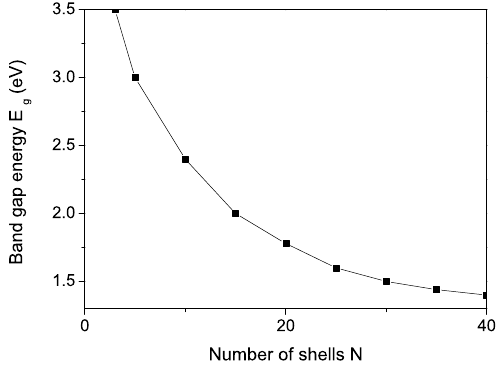
Figure 5. The band gap energy E g in CCO as function of the size.